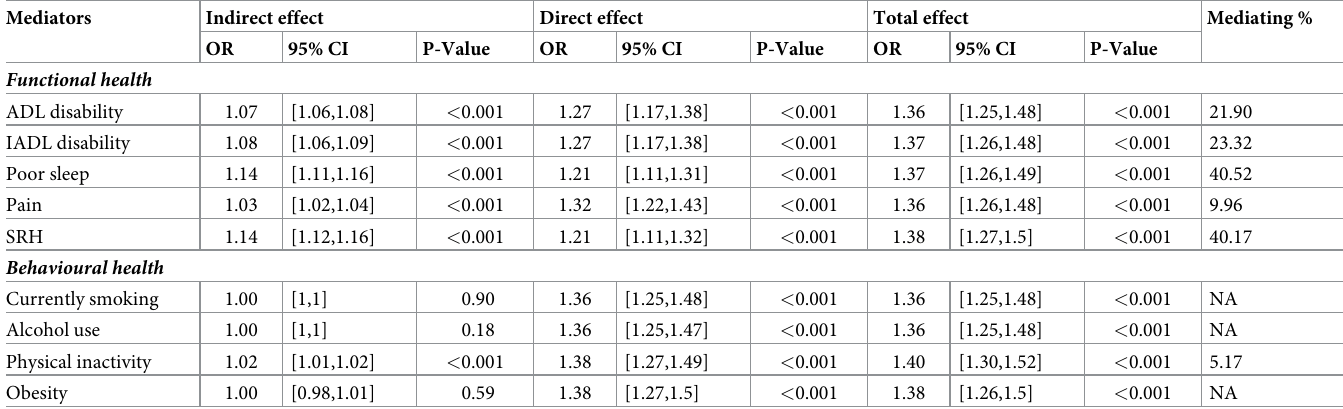
Table 5. Functional and behavioural mediators in the association between multimorbidity and depression